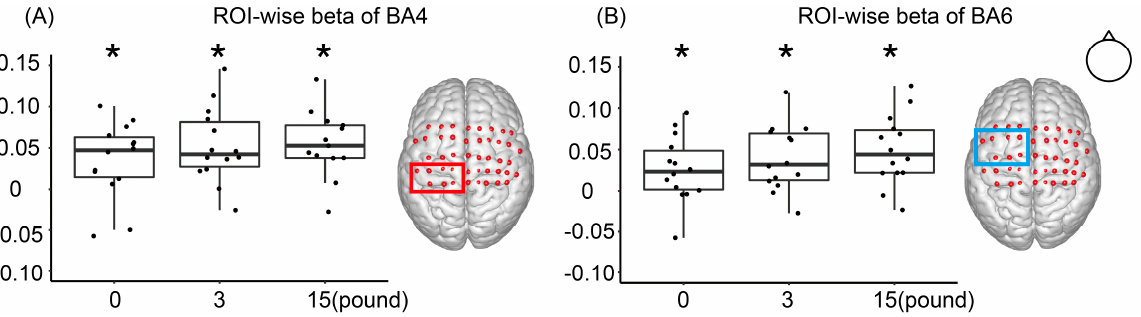
Figure 5. ROI-wise (Region of interest, ROI) activation. ( A ) BA4 was activated in all three conditions. ( B ) BA6 was activated in all three conditions. * p < 0.05, indicating beta-values were significantly greater than 0.